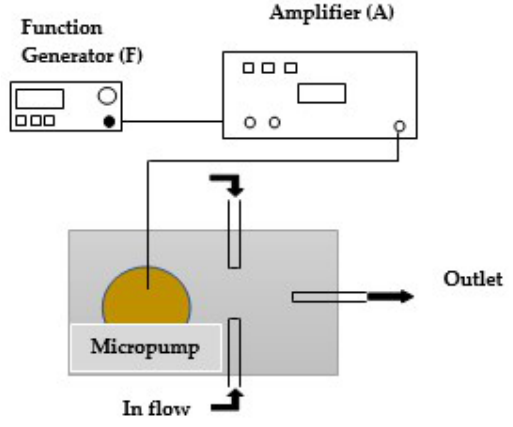
Figure 9. The schematic illustration of Experimental setup.